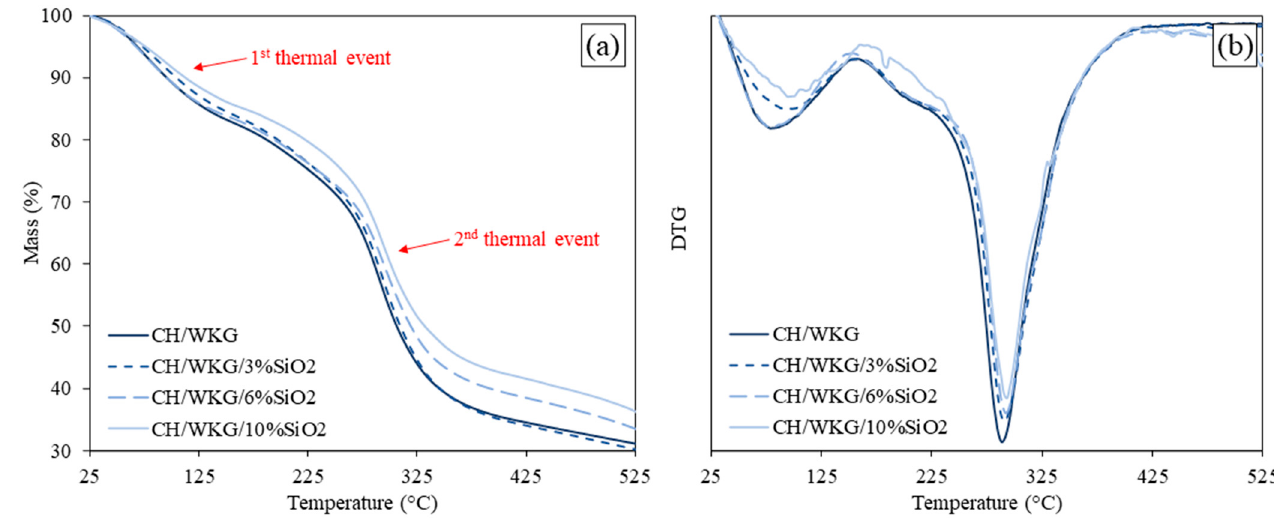
Figure 3. Thermogravimetric profile ( a ) of the films and its first derivative, DTG ( b ), with indication for the two main thermal events. Table 2. Temperatures of 5% mass loss and temperatures related to the two main thermal events.